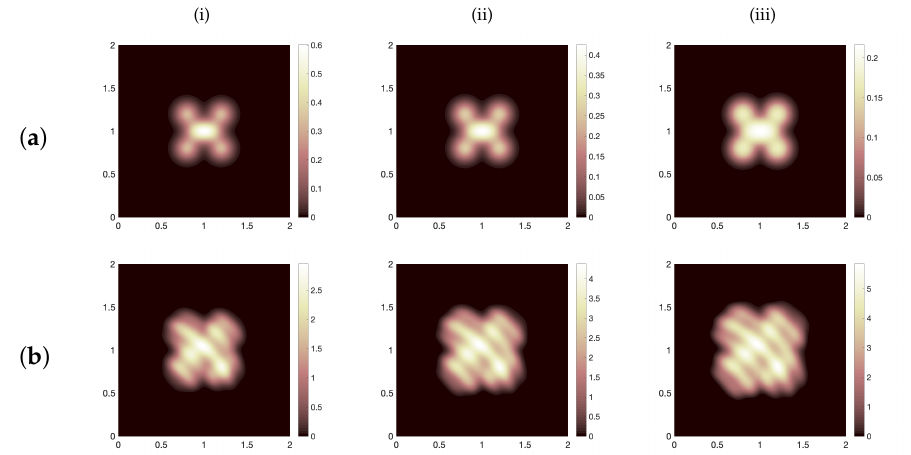
Figure 6. Comparison of spatial distribution of SARS-CoV-2 evolution at the final stage (120) (which is equivalent to approximately 14 days) for system (12) using the baseline values presented in Table 1 for multiple scenarios of the percentage variable ( ζ ) . ( a ) when ψ is represented by (10) and ψ : = 1, + − ( b ) when ψ is represented by (10) and ψ : = 1. (i) ζ : = 100%. (ii) ζ : = 150%. (iii) ζ : = − +